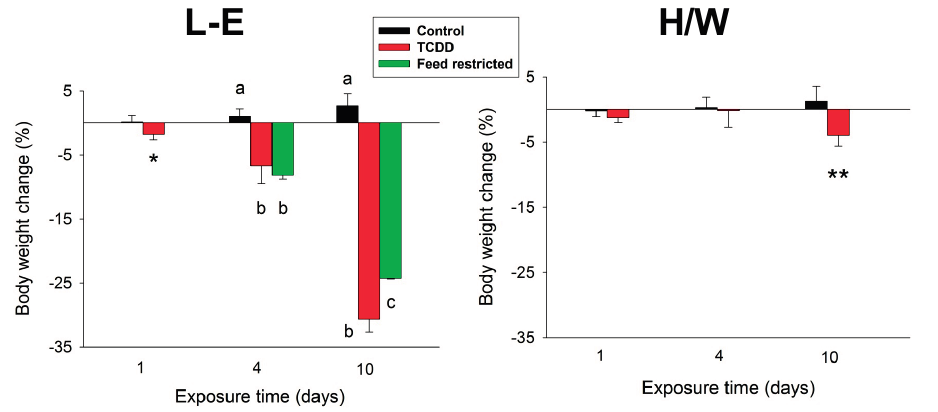
Figure 1. The effect of TCDD or feed restriction on body weight (mean ± SD) in L-E ( left panel) and H/W rats ( right panel) on days 1, 4 and 10 ( n = 5, except in the H/W strain on day 1 where n = 4). Columns with different letters at a single time-point differ significantly from one another ( p < 0.05). The asterisks denote a statistically significant difference ( t -test) from the corresponding control (L-E rats on day 1 and the H/W strain at all time-points) as follows: * = p < 0.05; ** = p < 0.01; *** = p <